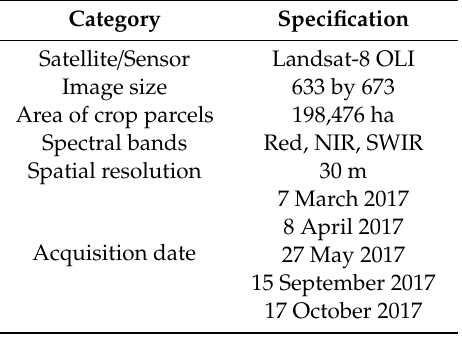
Table 2. Summary of Landsat-8 OLI images used for crop classification in